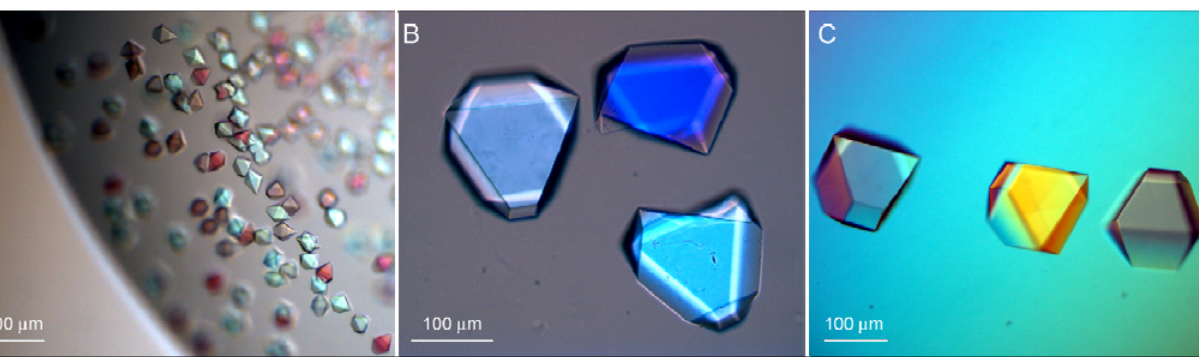
Figure 3. Microcrystals (10  5  7.5 µm to 20  10  15 µm) of native HvExoI ( A )